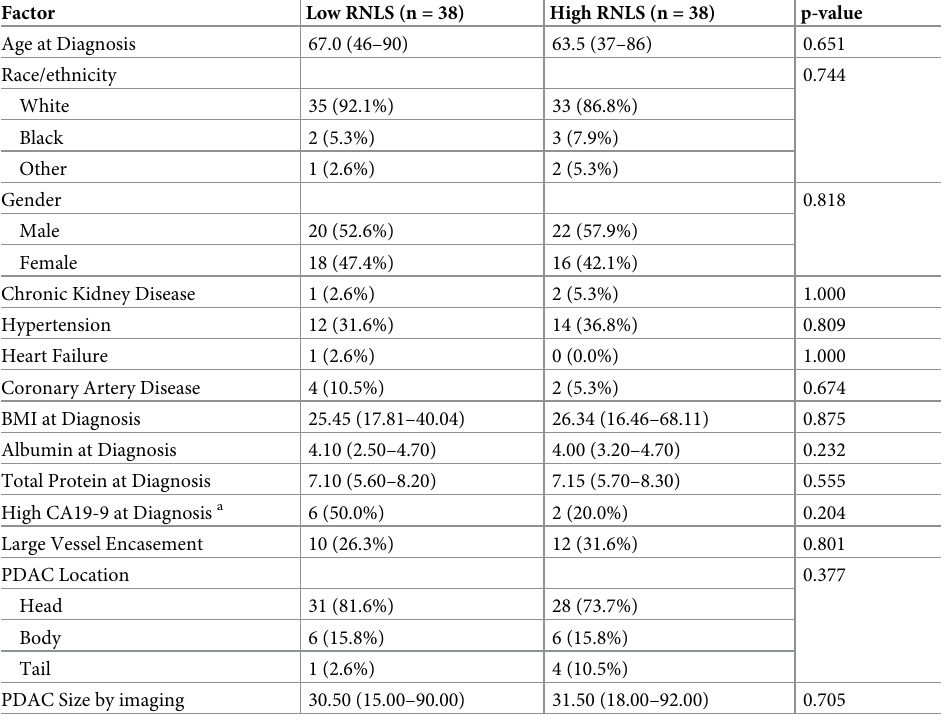
Table 4. Patient characteristics for low vs. high plasma RNLS levels in patients with locally advanced/borderline resectable (LA/BR) pancreatic adenocarcinoma